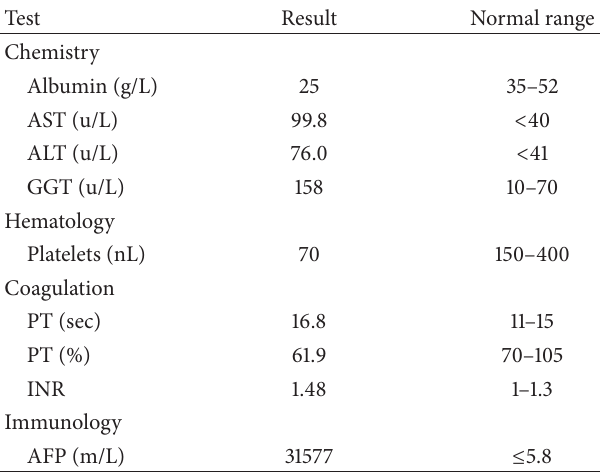
Table 1: Blood test